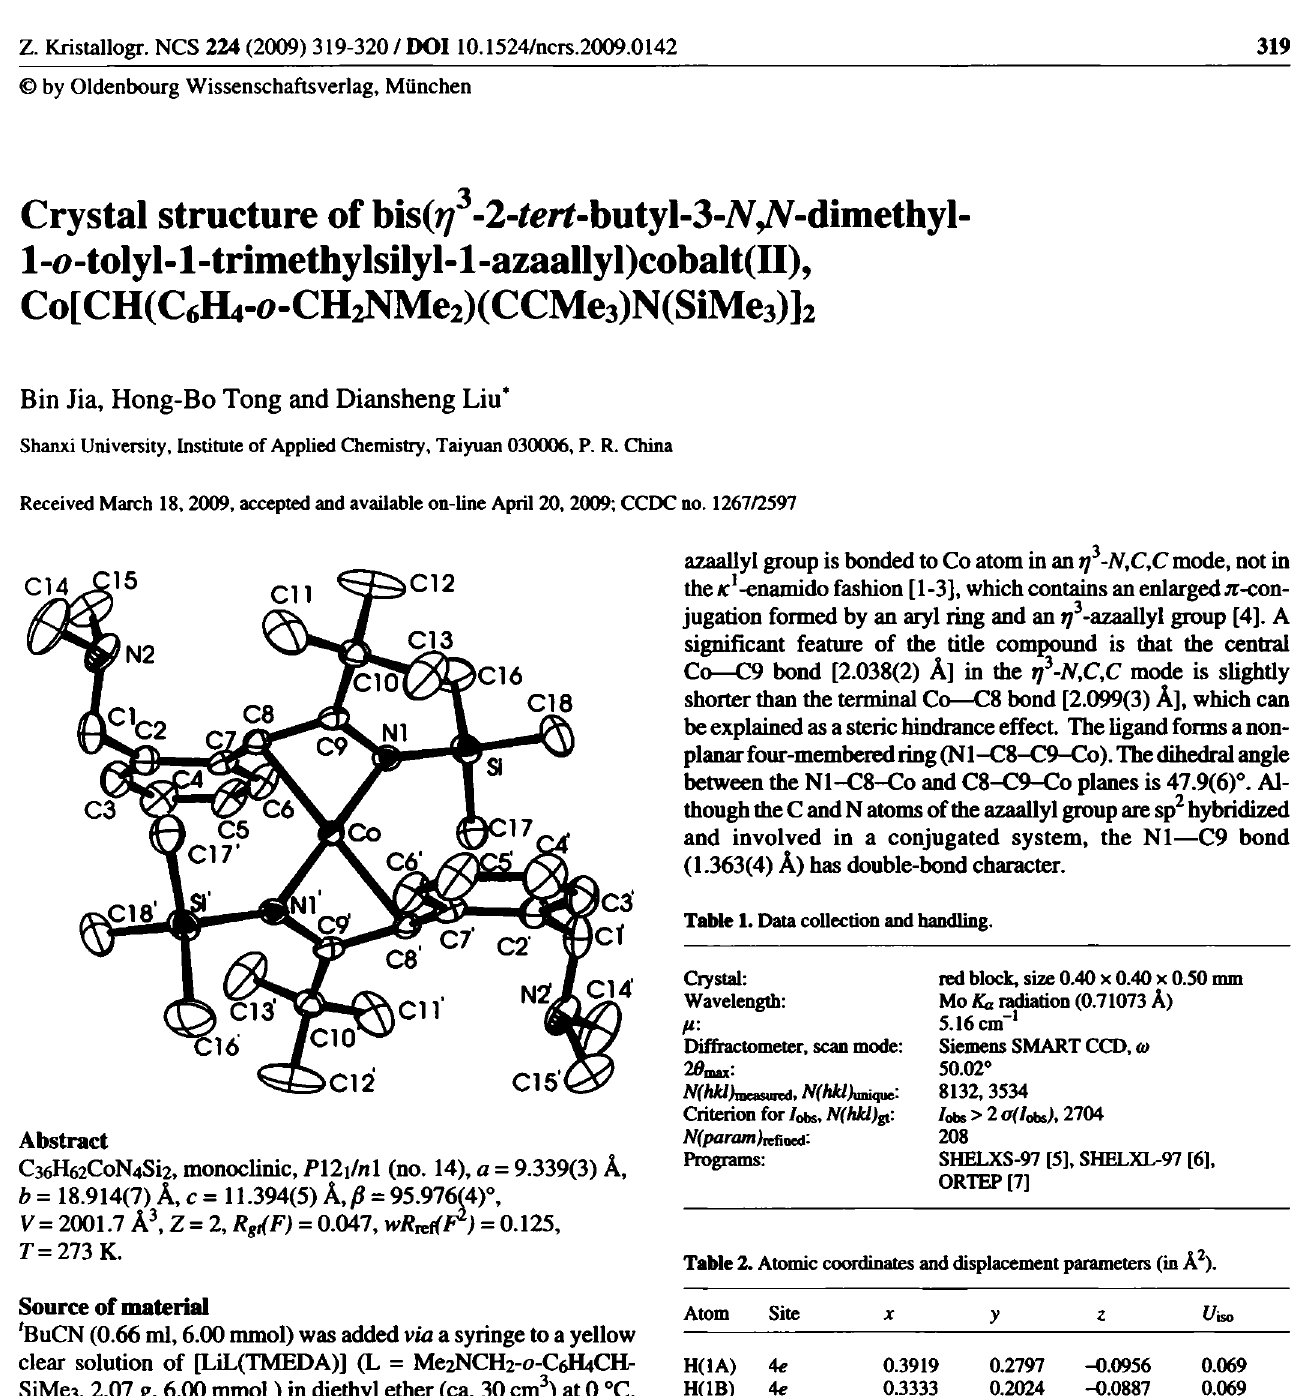
Table 2. Atomic coordinates and displacement parameters (in Â 2